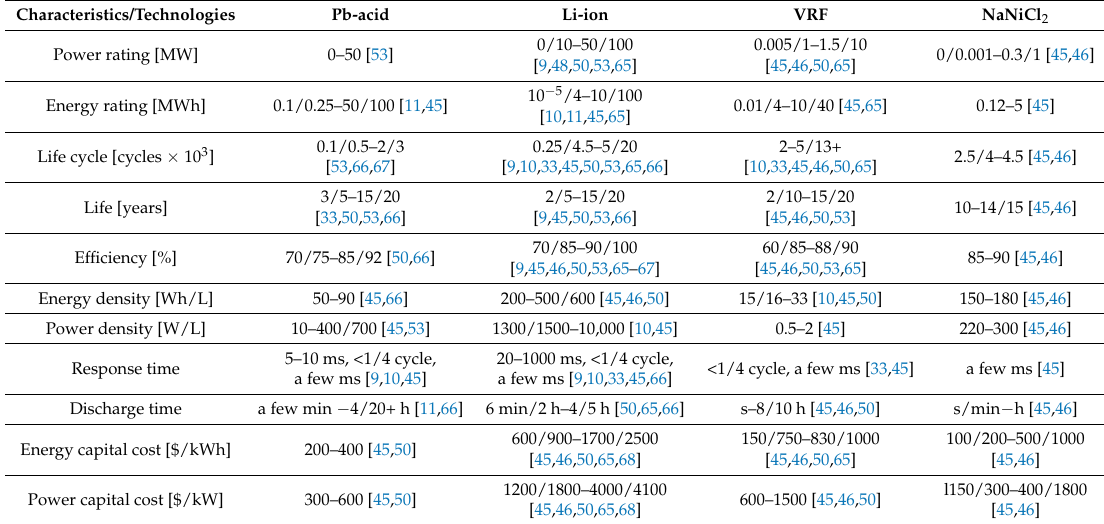
Table 4. Technical characteristics of the BESS technologies deployed in UK